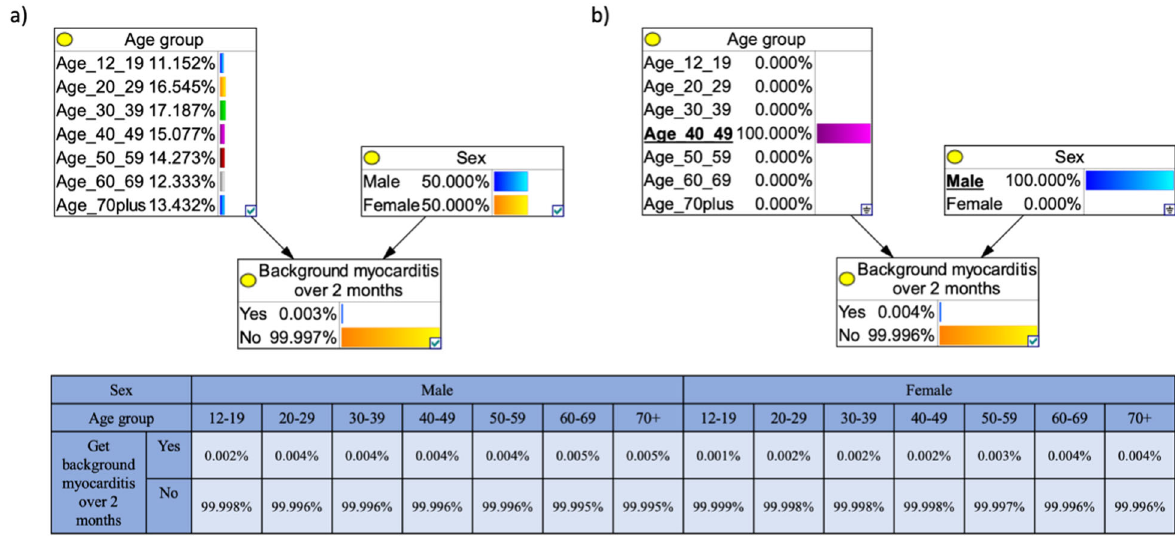
Fig. 5 Example Bayesian network (BN) for modelling the risk of developing background myocarditis over 2 months based on age and sex. The output node, ‘ Background myocarditis over 2 months ’ is the child of two linked (arrow) parent nodes, ‘ Age group ’ and ‘ Sex ’ . As these parent nodes do not have parent themselves, the probabilities of each of their possible states are determined by a prior distribution; the model adopts the age distribution of the Australian population and an even distribution of males and females. The conditional probability table for the outcome node ‘ Background myocarditis over 2 months ’ , gives the probability for each state of this node dependent on the parent node states. a In the default state, the BN shows that the chance of developing background myocarditis (not from COVID-19 or the P fi zer vaccine) over 2 months is 0.003% (e.g., in a population of 100,000 people, we expect three to get myocarditis in a 2-month period). b An example of scenario analysis showing the chance of a 40 – 49-year-old male (underlined) developing background myocarditis over 2 months, the model calculates a 0.004% chance of